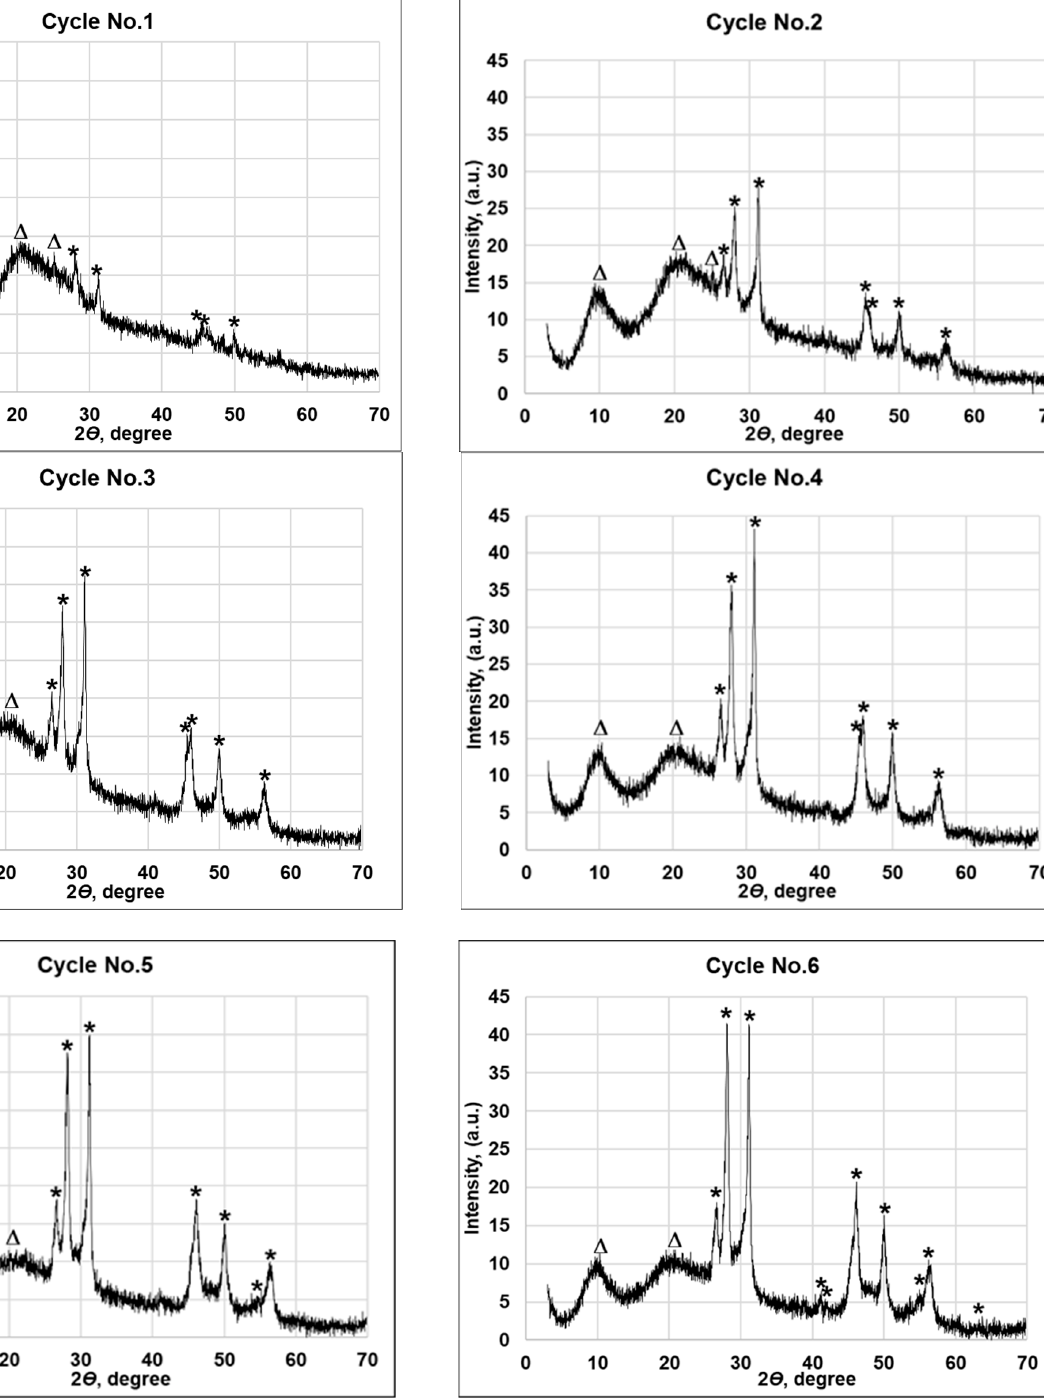
Figure 4. X-ray diffraction patterns of wool fibers with coatings of Cu x Se obtained with different numbers of cycles. Peaks were identified and assigned as follows: (*)—hexagonal klockmannite Cu 0.87 Se (JCPDS no. 83-1814); ( ∆ )—wool fiber. Table 2. XRD 2 θ peaks and their ascription of a coating of Cu x Se formed on the wool fiber surface.